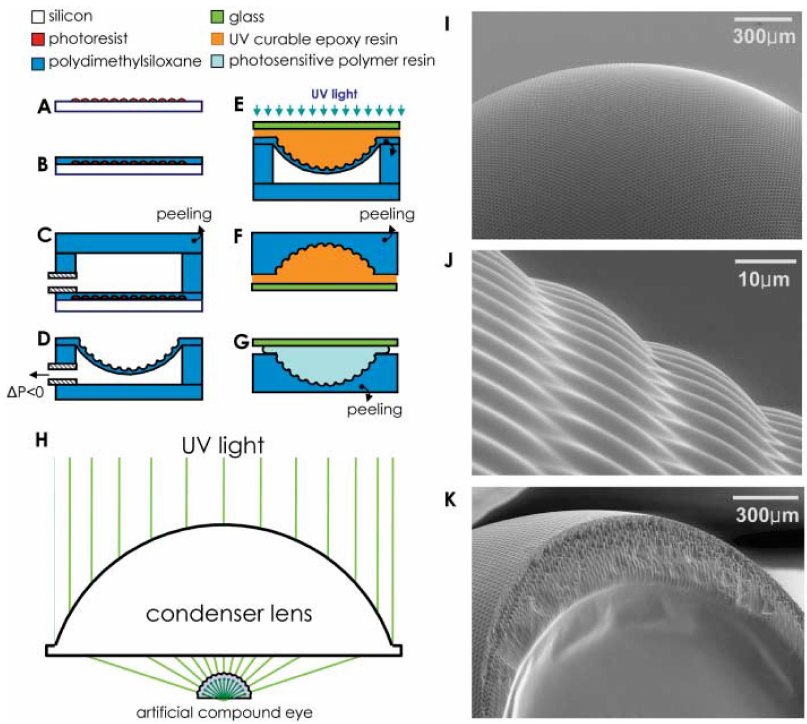
Figure 9. Schematic diagrams of the process sequence of the SU-8-based biomimetic artificial compound eyes: ( A ) micro-lens array formation by photoresist reflow; ( B ) PDMS molding; ( C ) PDMS bonding; ( D ) PDMS membrane deformation by applied negative pressure; ( E ) replication with UV curable polymer resin; ( F ) PDMS molding; ( G ) SU-8 molding; ( H ) UV exposure through a condenser lens; SEM images of an artificial compound eye ( I – K ). Reprinted with permission from [36], copyight 2006 American Association